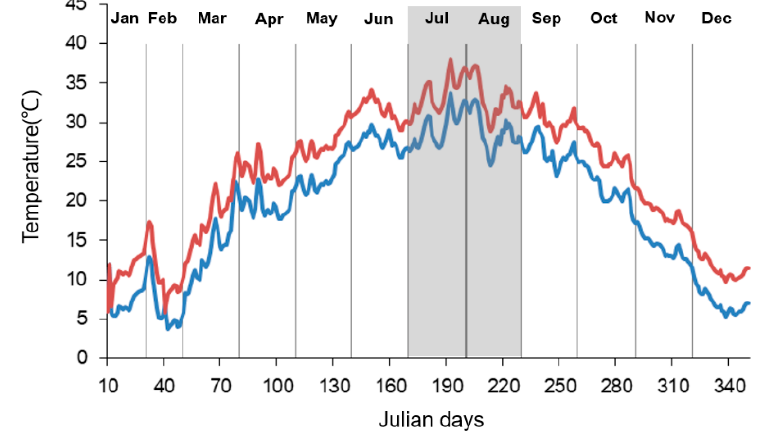
Figure 1. Mean daily water temperature in the ambient (blue line) and heated (red line) tanks. Shaded area shows the period of this study.